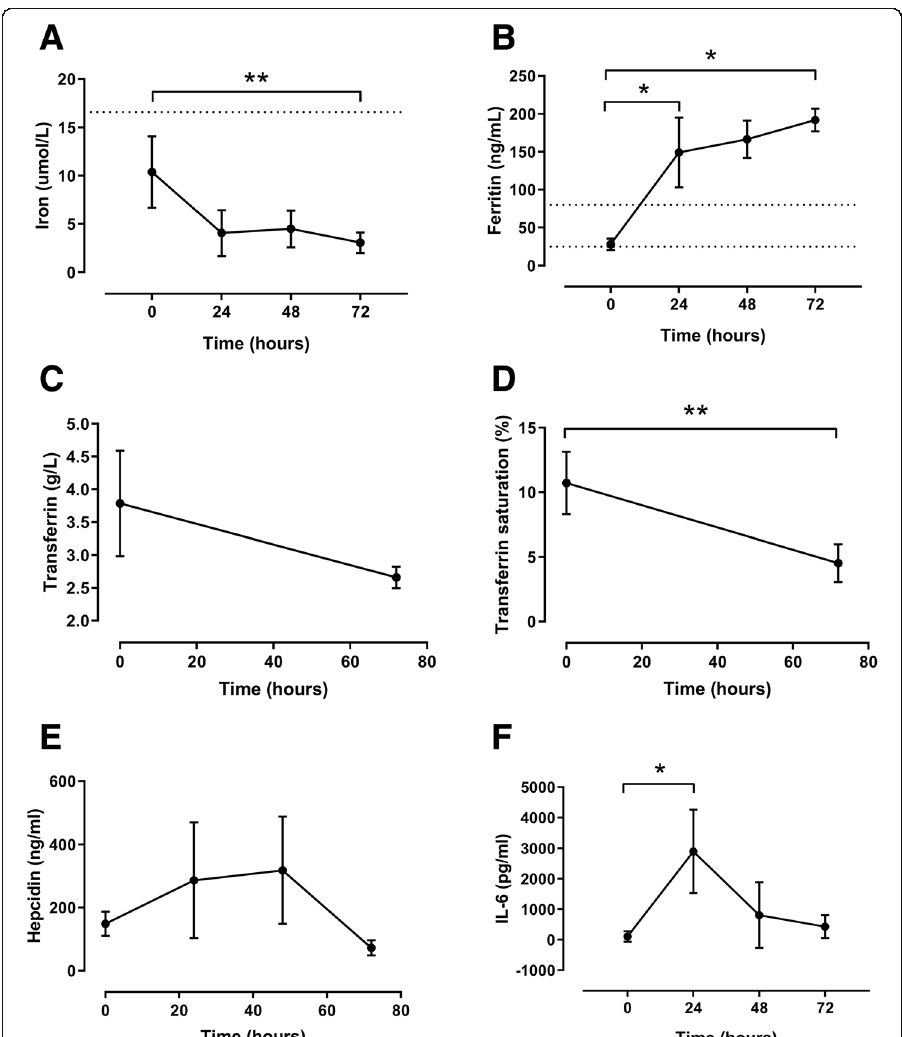
Fig. 4 Iron parameters in pigs with pneumosepsis. Levels of iron ( a ), ferritin ( b ), transferrin ( c ), transferrin saturation ( d ), hepcidin ( e ), and IL-6 ( f ) in pigs inoculated with 15 mL of 10 8 CFU of a log-phase culture of P. aeruginosa into each lung lobe. N = 5 and data are expressed as mean + SD ( n = 5). *** P < 0.001, ** P < 0.01, * P < 0.05. Dotted lines represent reference